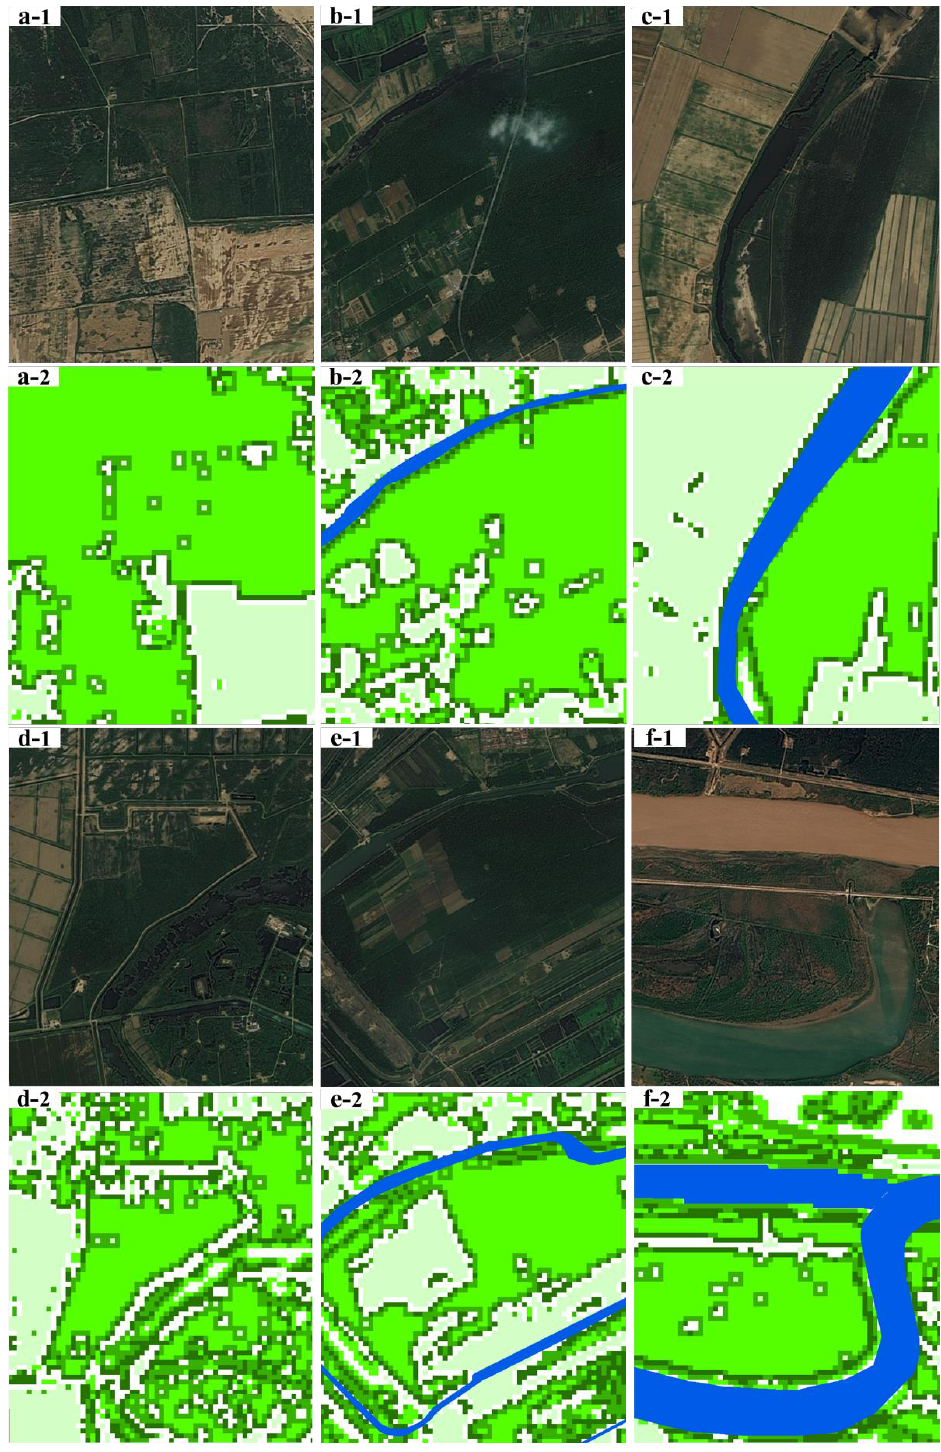
Figure 9. The six verification areas from Map World: ( a1 – 2 , b1 – 2 ) potential HNVf area with high natural vegetation; ( c1 – 2 , d1 – 2 and e1 – 2 ) potential HNVf area in farmland edges; ( f1 – 2 ) extremely high HNVf